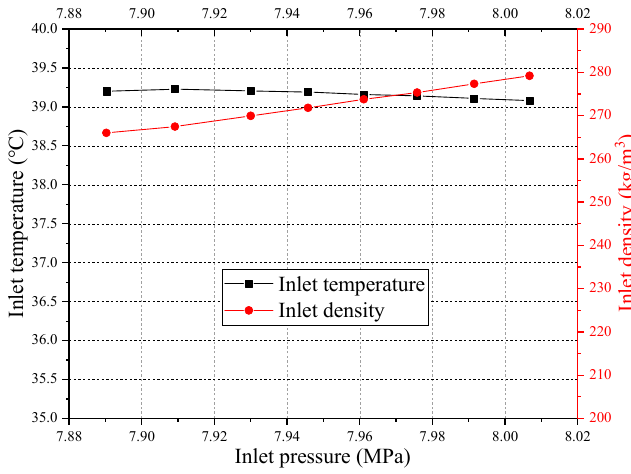
Figure 19. The inlet condition of the stepped staggered labyrinth seal test.